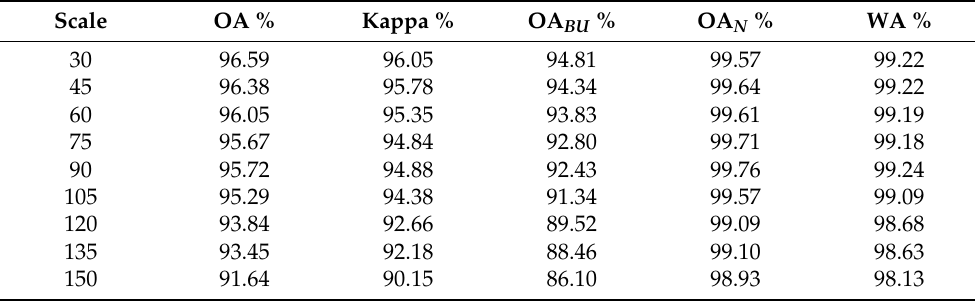
Table 7. Accuracy statistics from scale 30 to 150 with the average values from 50